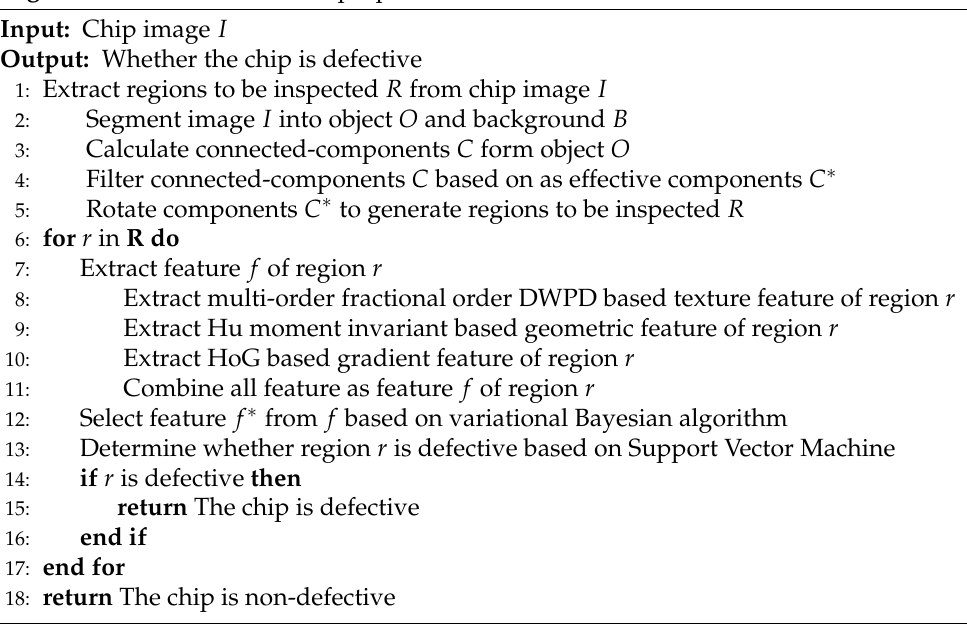
Algorithm 1 Pseudcode of the proposed method.